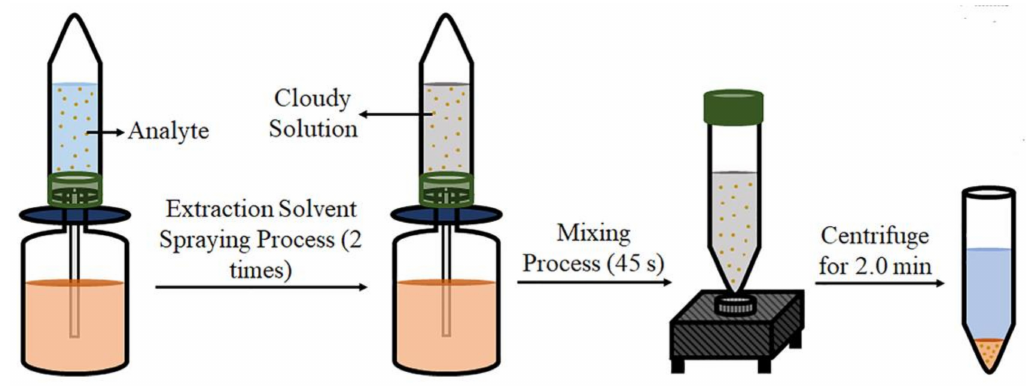
Figure 4. Schematic diagram of the vortex-assisted spraying-based fine droplet formation liquid-phase microextraction. Reproduced with permission of Wiley from reference